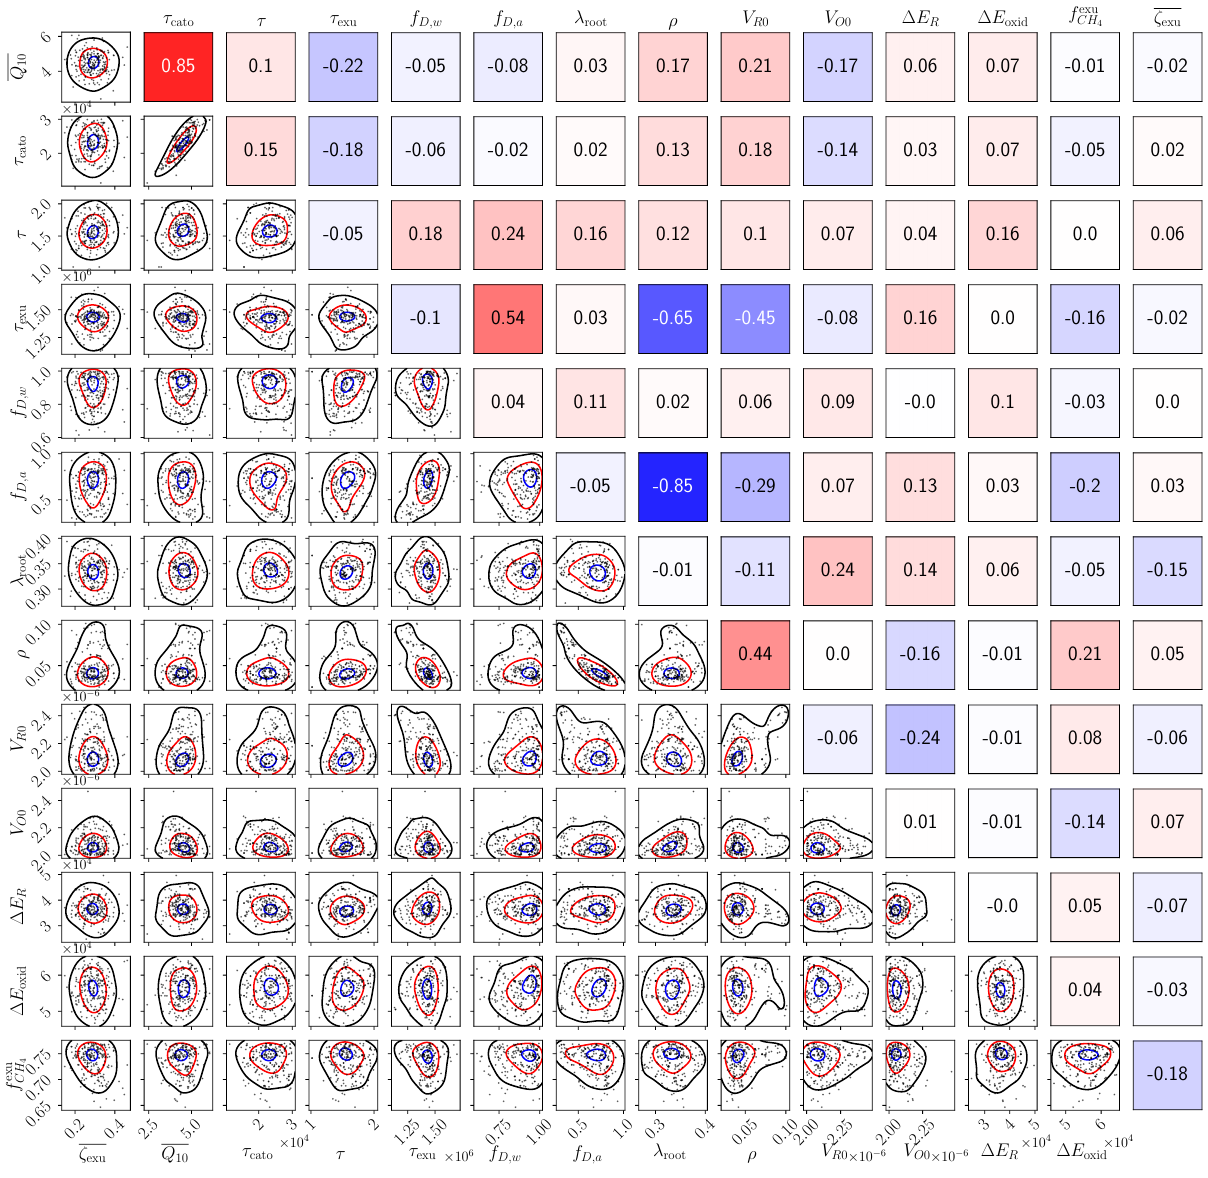
Figure 4. Posterior distributions of the parameters from the importance sampling. The two-dimensional marginal distributions of the posterior distribution are shown in the triangle on the lower left (labels on the left and at the bottom), and the correlations between parameters are shown in the upper triangle on the right (labels on the left and at the top). The images in the lower left triangle show the 90% (black), 50% (red), and 10% (blue) contours, and points from a random sample of the posterior (black dots). On the upper right, each plot shows correlation coefficients between parameters, color coded to show negative correlations in blue and positive in red. The units are listed